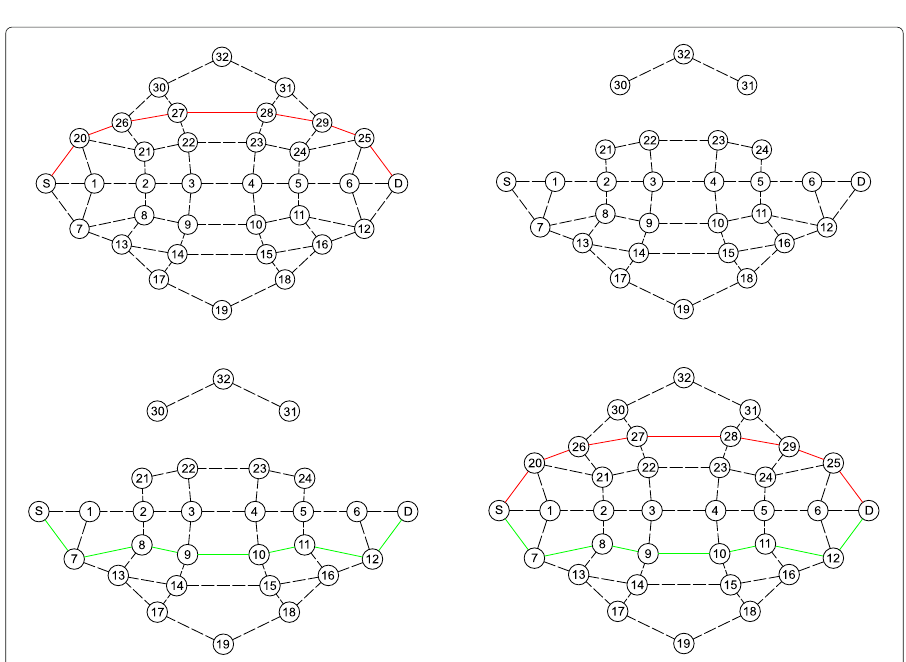
Fig. 3 Method 2 Mock Suurballe’s. a Step 1. Dijkstra’s algorithm is used to find a path from source to destination. b Step 2. Nodes in the first path are removed from the graph. c Step 3. A second path is